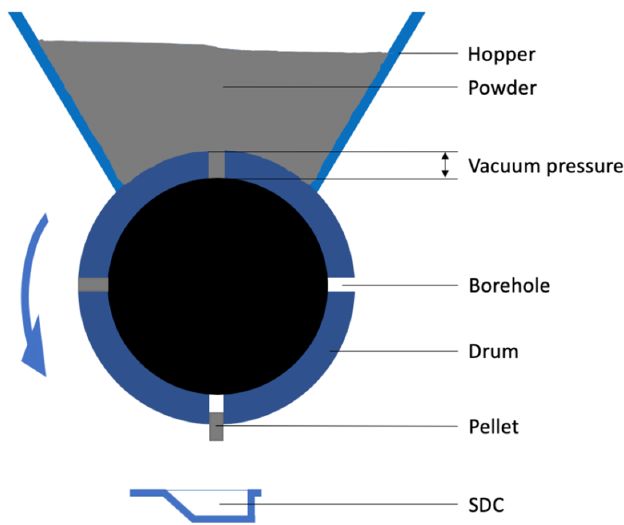
Figure 1. A schematic representation of the vacuum drum filler used in this study.